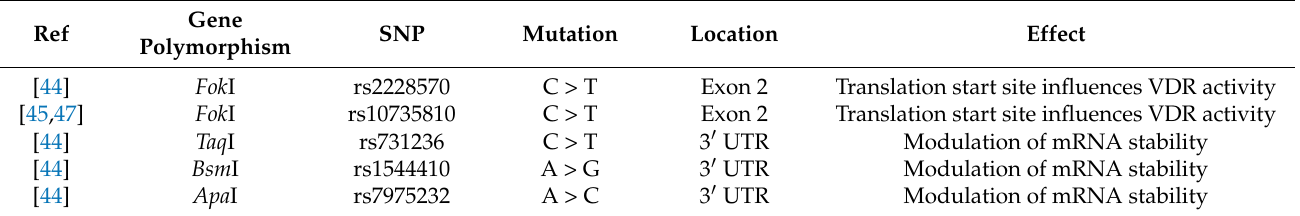
Table 1. Single nucleotide polymorphisms of vitamin D receptor gene and potential